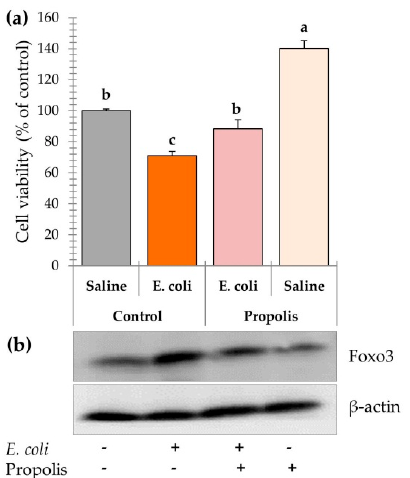
Figure 3. The effect of dietary propolis supplementation (1 g/kg diet) and E. coli challenge (10 7 colonies/hen) on ( a ) leucocyte cell viability percentage and ( b ) the levels of Foxo3 expression in PBMCs. Column with different above letter significantly differ ( p <